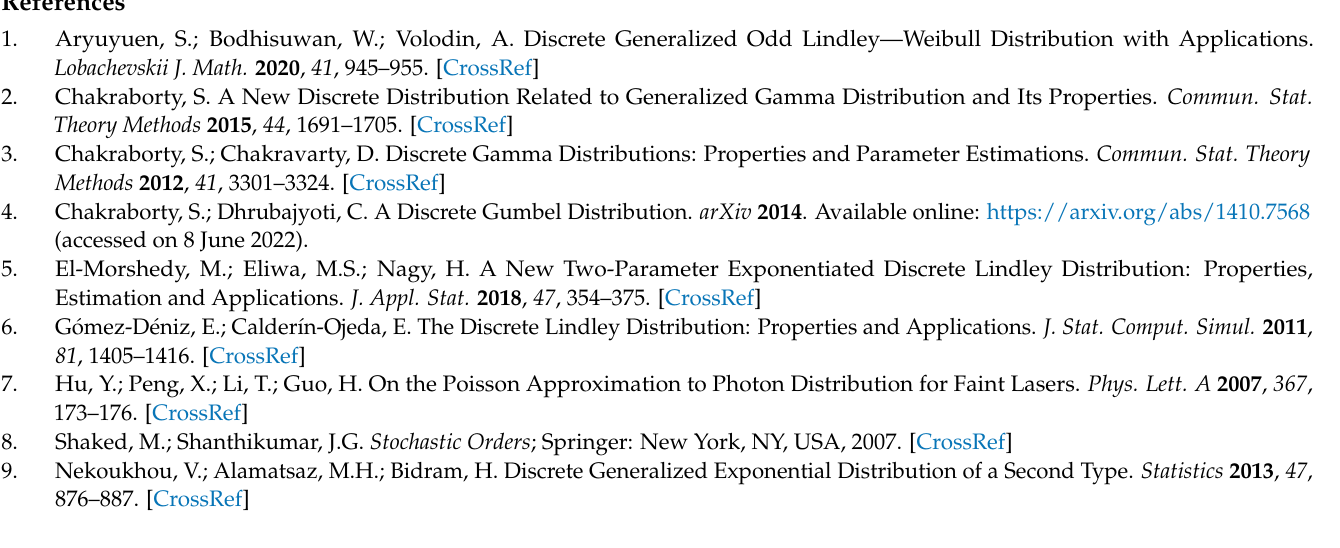
Figure 10. Fitted plot of Negative Binomial distributions for given data set .